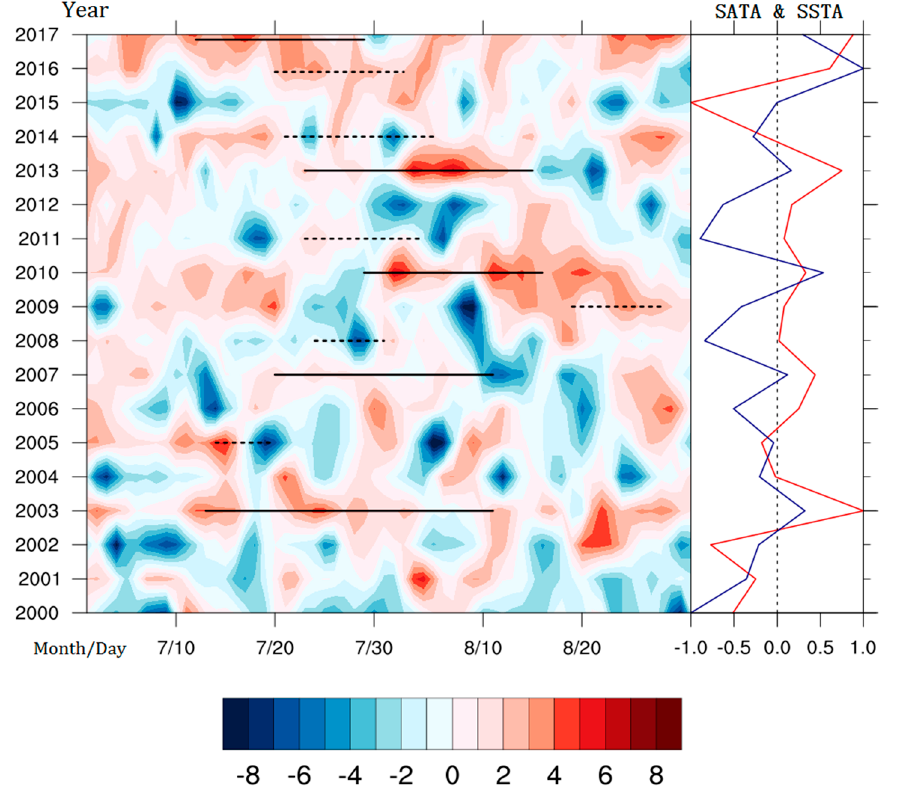
Figure 10. Temporal evolutions (left part) of domain-averaged (25 ◦ N–30 ◦ N, 115 ◦ E–125 ◦ E) daily 500 hPa geopotential height anomalies in two peak summer months (July and August) from 2000 to 2017 (shading, dagpm); the horizontal black solid (dashed) lines, respectively, highlight 11 EHW events persisting longer (shorter) than 15 days. The two zig-zag lines on the right side are, respectively, standardized domain-mean (25 ◦ N–30 ◦ N, 115 ◦ E–125 ◦ E) surface air temperature anomalies (SATA) averaged through July and August (in red color) and the associated index of the sea surface temperature anomaly (SSTA) (in blue color, the detail definition of this SSTA index can be found in the context).